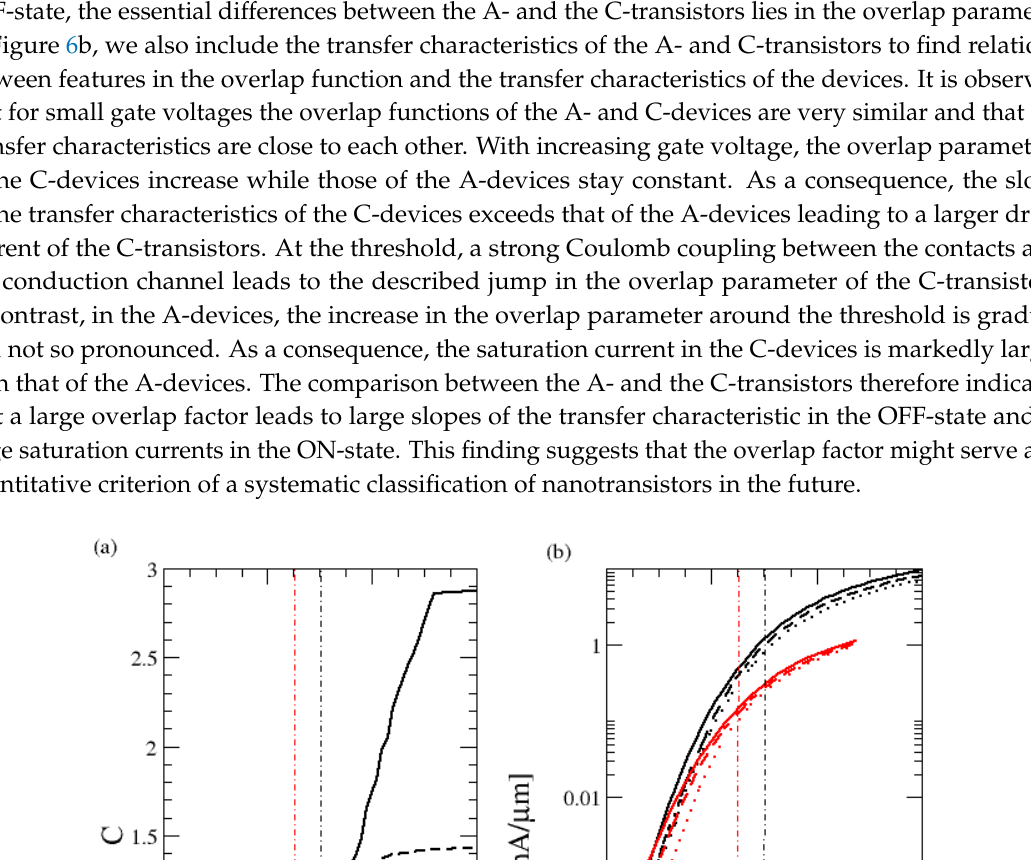
is marked with a black (red) G